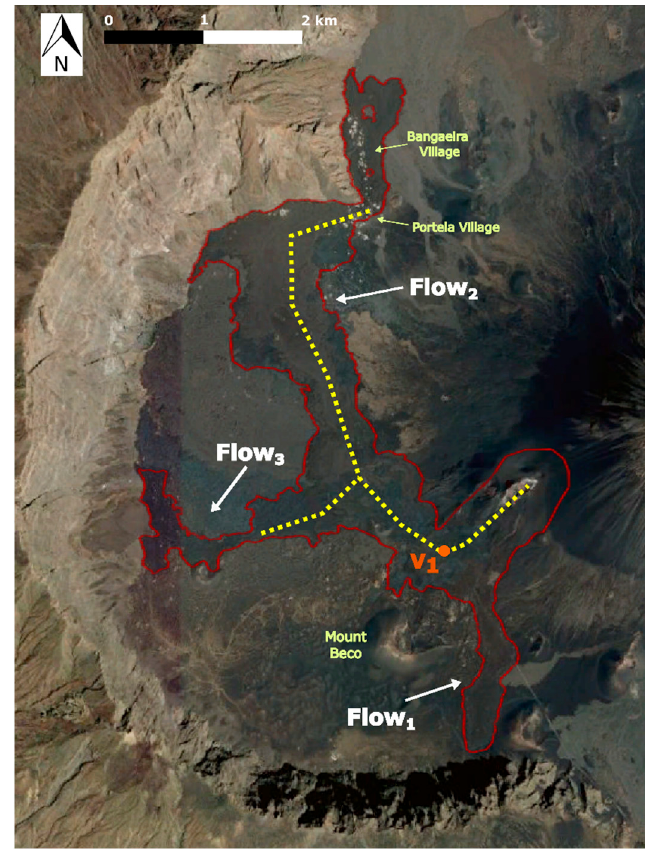
Figure 8. Interpretative model. Outline of the final lava flow field (red line) with path of lava tubes (yellow dotted line). The position of V1 at the base of the eruptive fissure is also shown.